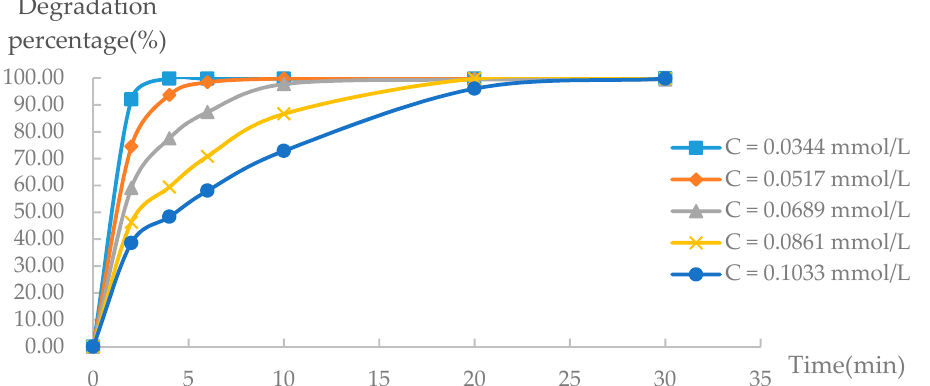
Figure 6. The influence of different initial trimethoprim concentrations (0.0344–0.1033 mmol/L) on trimethoprim degradation.